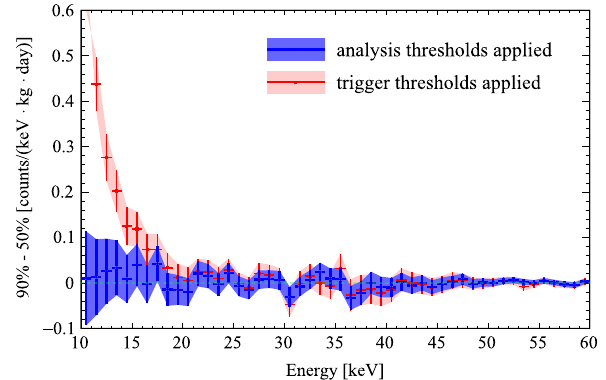
Fig. 3 OT χ 2 selection efficiency corrected rate difference between the background spectra calculated for OT χ 2 90% and OT χ 2 50% . (See Sect. 4.3 for a description of analysis and trigger